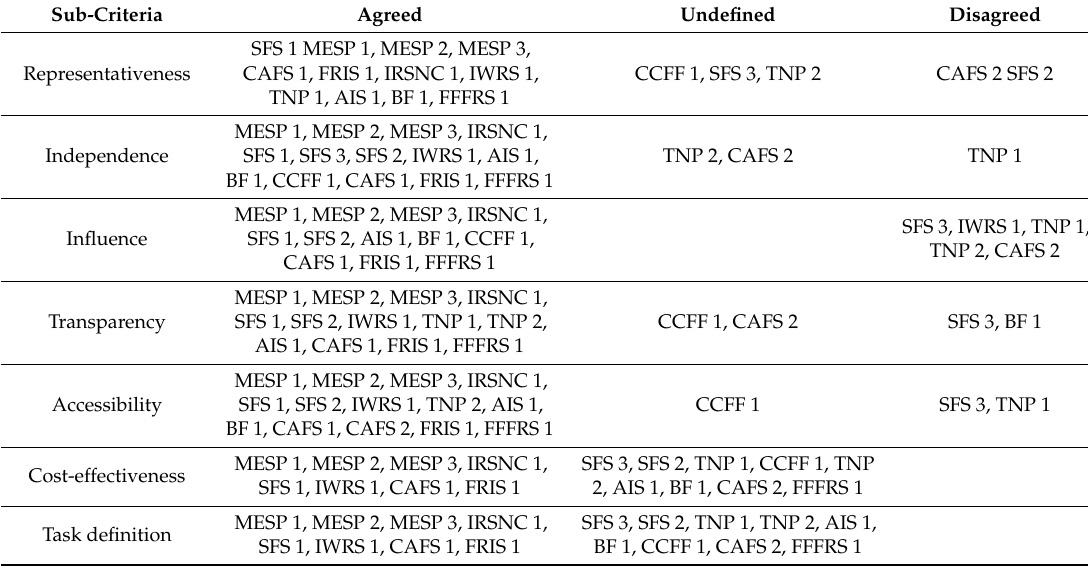
Table A1. Distribution of Interviewees According to the Evaluation Sub-Criteria for an Effective Participatory Process.